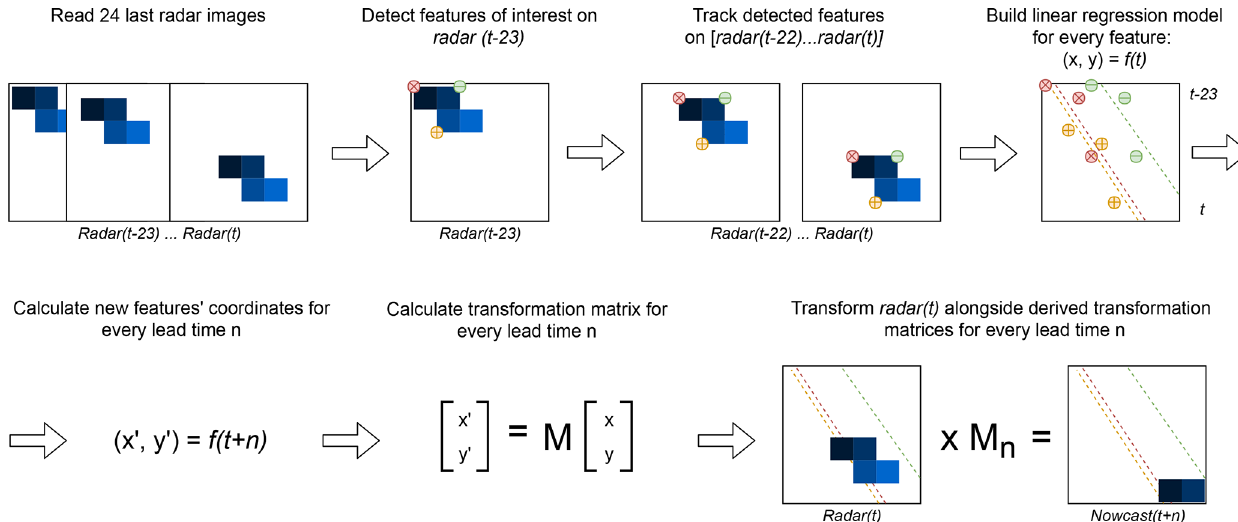
Figure 2. Scheme of the Sparse model.